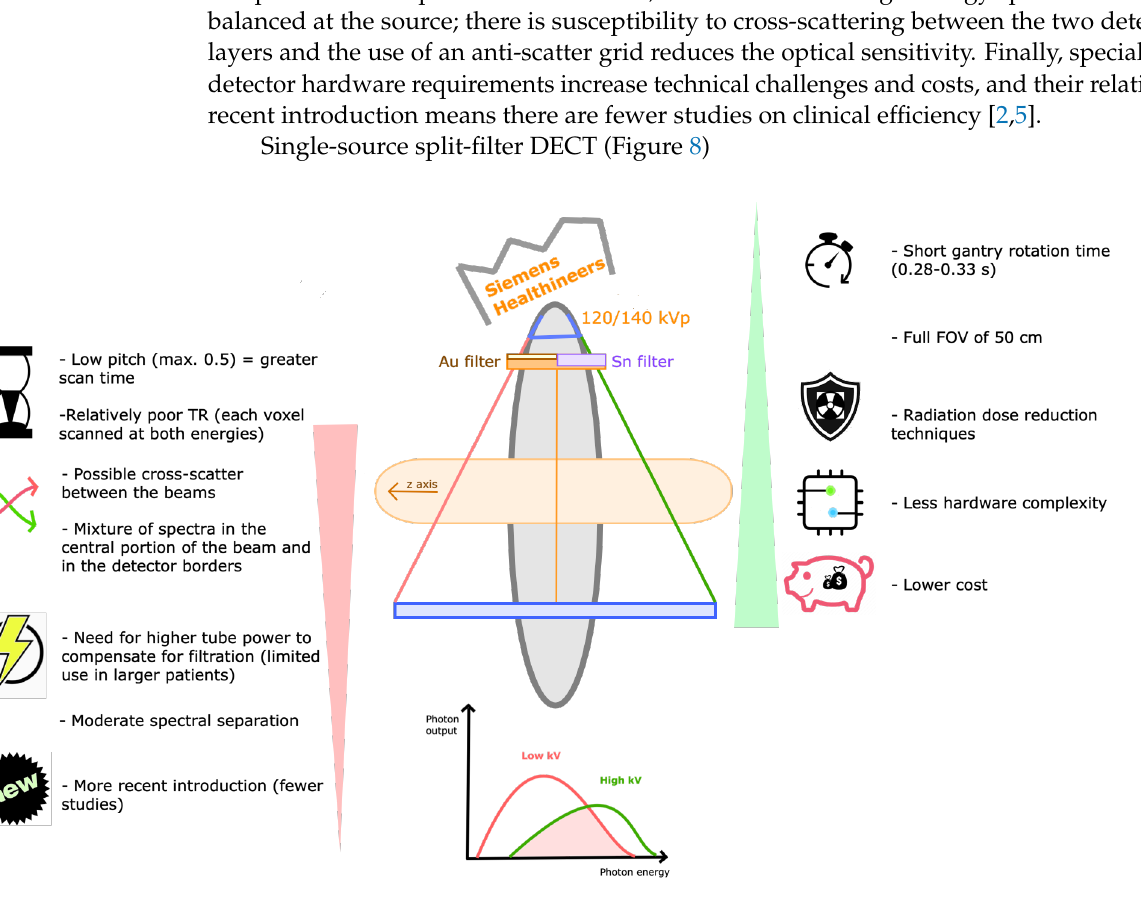
Figure 8. Single-source split-filter DECT. Schematic representation of single-source split-filter DECT scanner and its drawbacks (listed on the left) and strengths (listed on the right). These scanners (commercialized by Siemens Healthineers) are composed of a single source and detector, with a split-filter of gold (Au) and tin (Sn) at the x-ray tube, respectively, filtering the low- and high-energy beams. Each half of the split beam is captured at corresponding halves of the detector. FOV—field of view, kVp—peak kilovoltage, TR—time resolution.